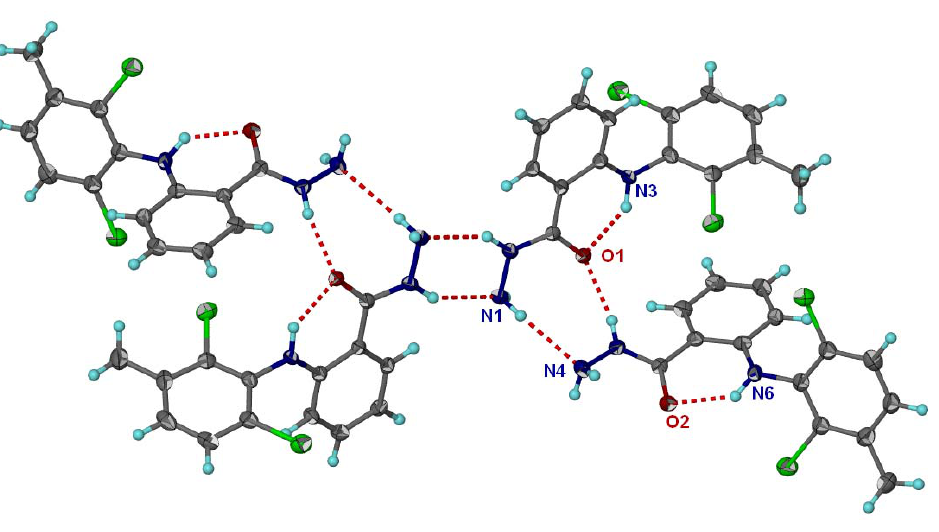
Figure 2. Crystal packing of hydrazide 3c